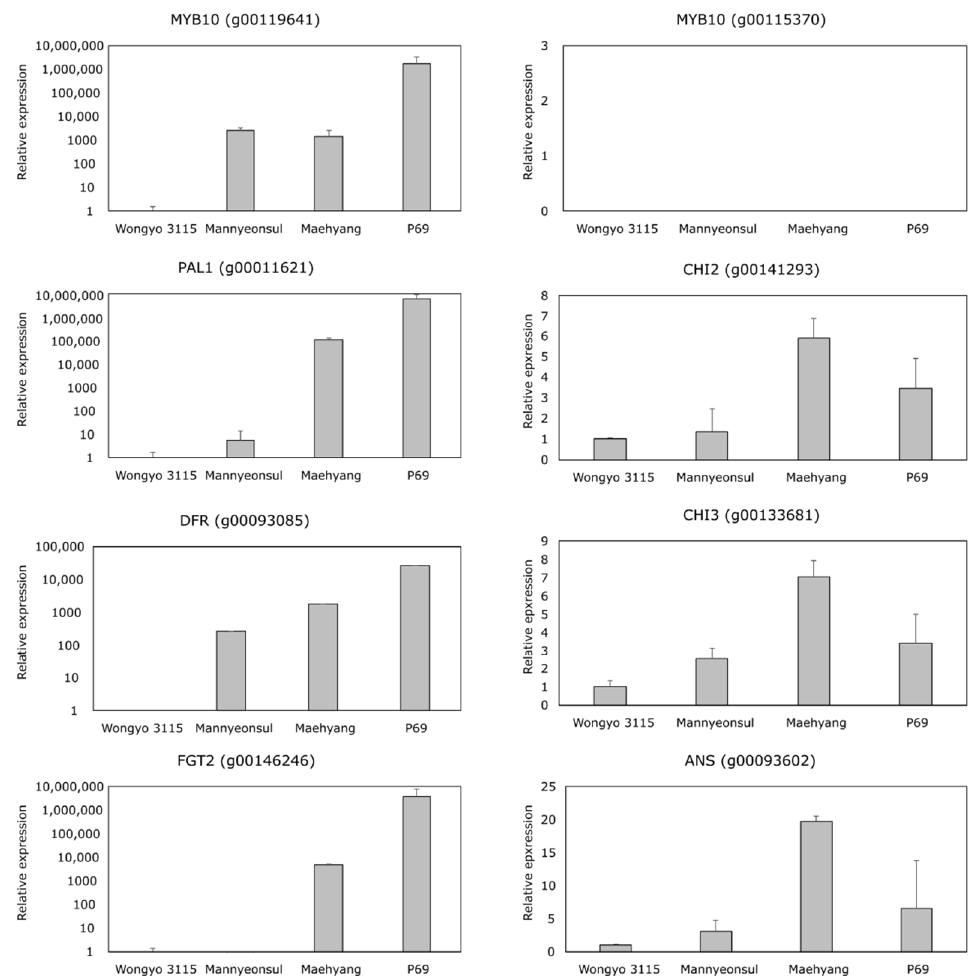
Int. J. Mol. Sci. 2021 , 22 , x FOR PEER REVIEW Figure 4. Relative expression analysis of the vital genes involved in the anthocyanin pathway using real-time PCR. The values are relative expression level compared to ‘Wongyo 3115’ and standard deviation.